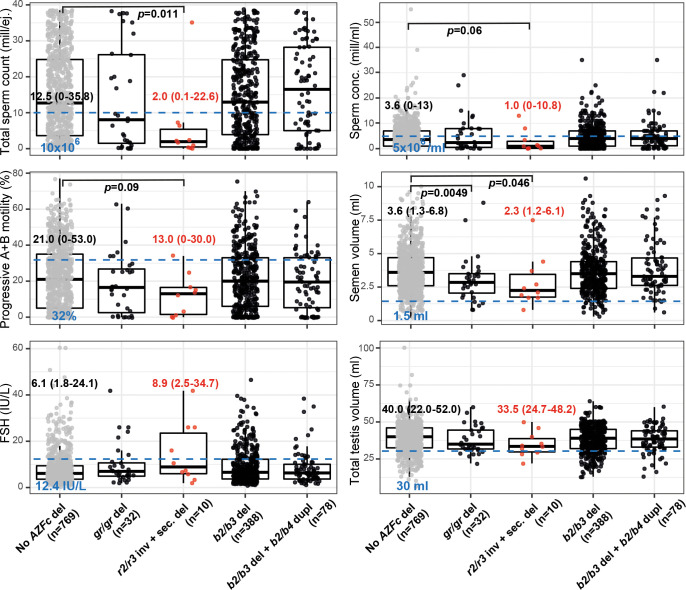
Distribution of andrological parameters in the idiopathic male factor infertility cases (total sperm counts 0–39 × 106) subgrouped based on the structure of the AZFc region.The median (5–95% range) of each parameter is shown for cases carrying the r2/r3 inversion plus secondary deletions compared to infertile men without any AZFc deletion. The pairwise Wilcoxon rank–sum test was applied to estimate the statistical difference between groups. Statistical significance threshold after correction for multiple testing was estimated p<1.0×10−3 (a total of 5 tests × 10 independent parameters). Threshold values (shown in blue) for sperm parameters corresponding to severe spermatogenic failure are based on international guidelines (World Health Organization, 2010). For reproductive hormones, reference values of the laboratory service provider are shown. The empirical threshold for the total testis volume was based on routinely applied clinical criteria at the AC-TUH. For full details, see Supplementary files 3 and 12.